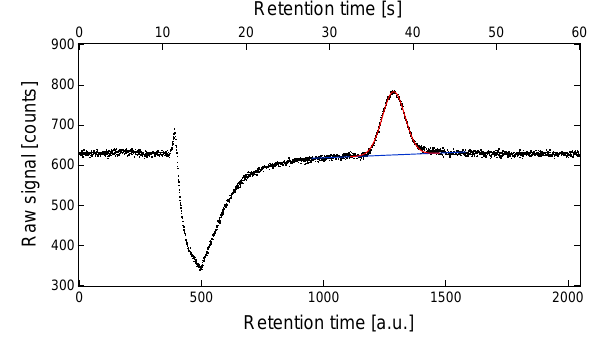
Fig. 1. Typical GC-PID chromatogram of pyrrole in humid air. Pyr- role is detected in a retention window of 1000–2000a . u . (35–55s) and needs to be well separated from the water peak (400–1000a . u . ). Added is the Gaussian fit for peak integration in red and the applied baseline in blue. It can be noted that the baseline is slightly tilted due to the water peak.